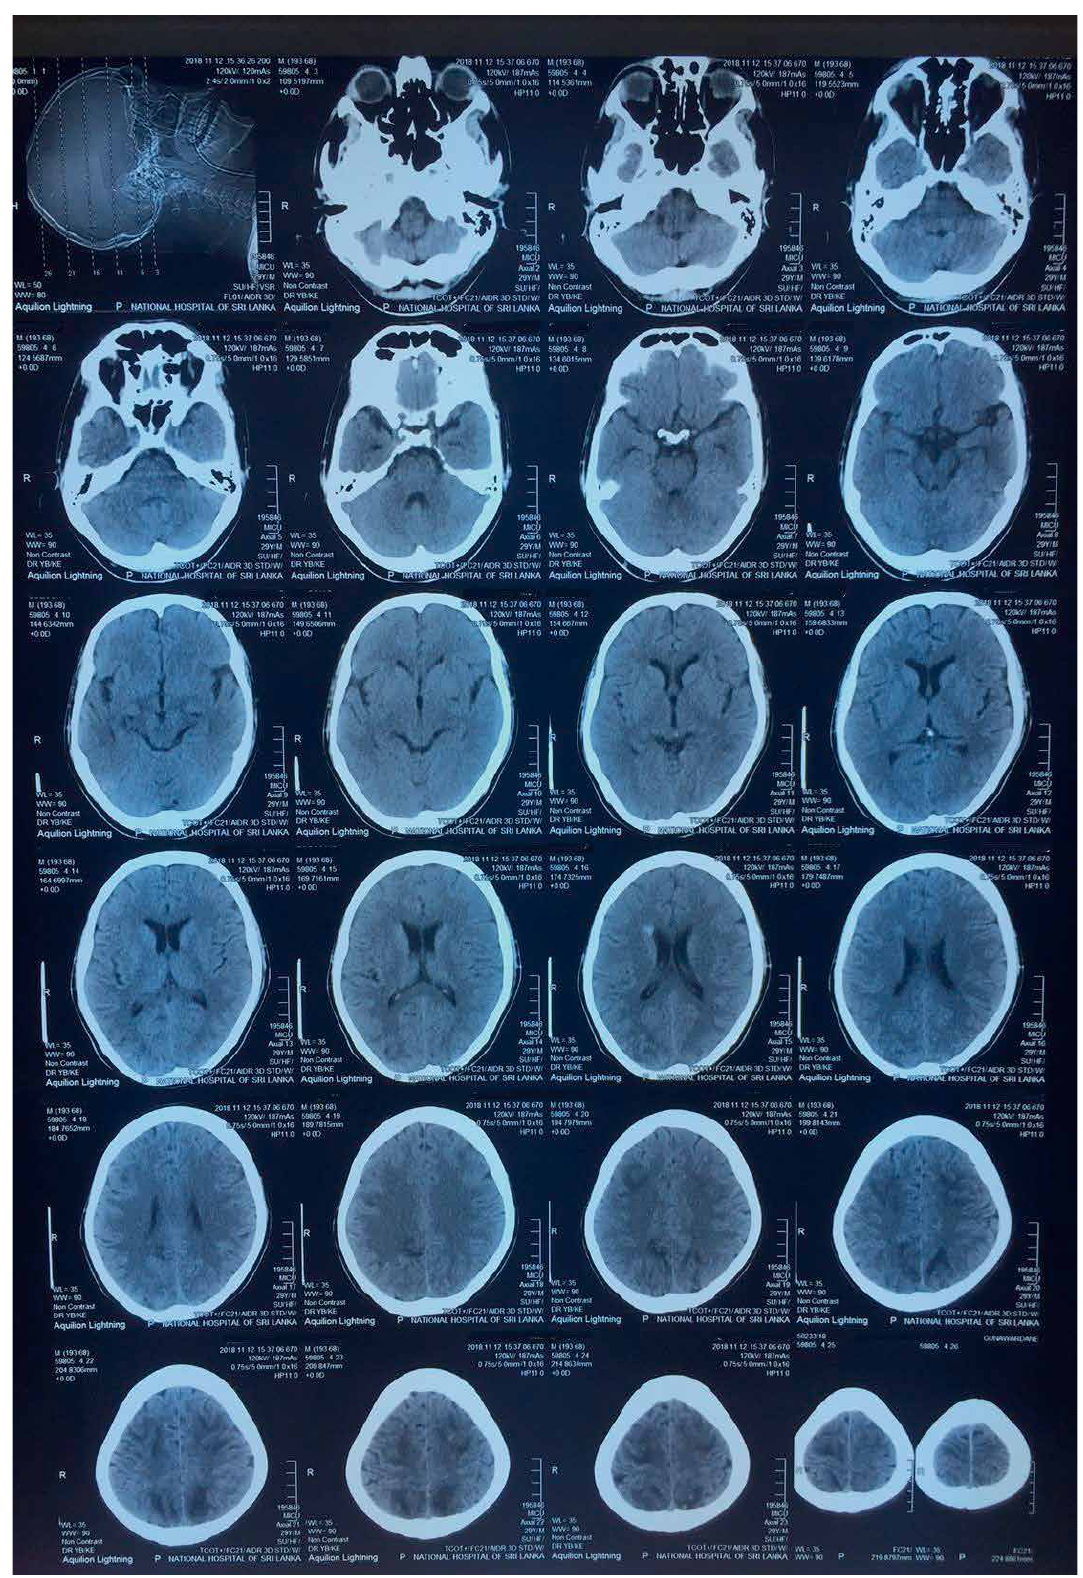
Figure 1: Noncontrast computerised tomography showing hypodense areas involving bilateral occipital